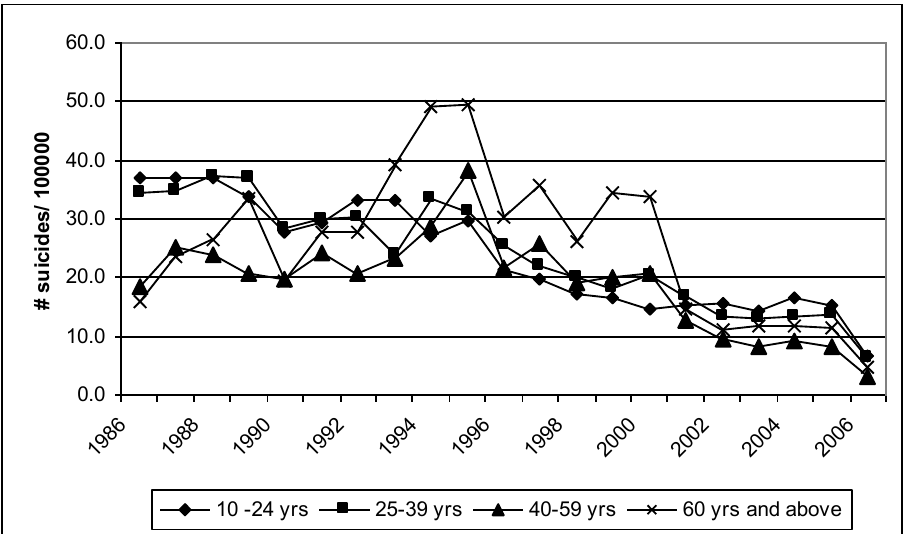
(Source: Department of Police, Sri